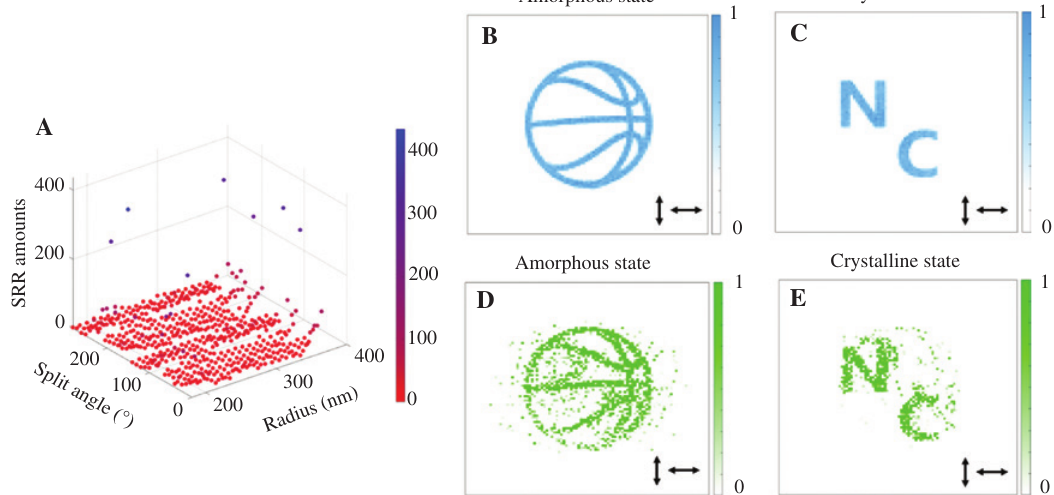
Figure 3: Double hologram images reconstructed from a single hybrid metasurface under amorphous/crystalline state. (A) Selected SRR amount distribution. (B, C) Numerical reconstructions using the Fresnel diffraction theory. (D, E) Simulated reconstructions using full-wave calculations based on FDTD. Black arrows indicate output/input